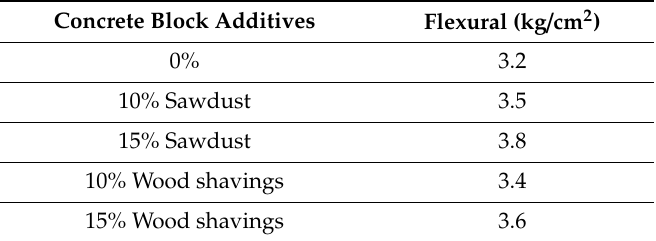
Table 3. Results of flexural tests in